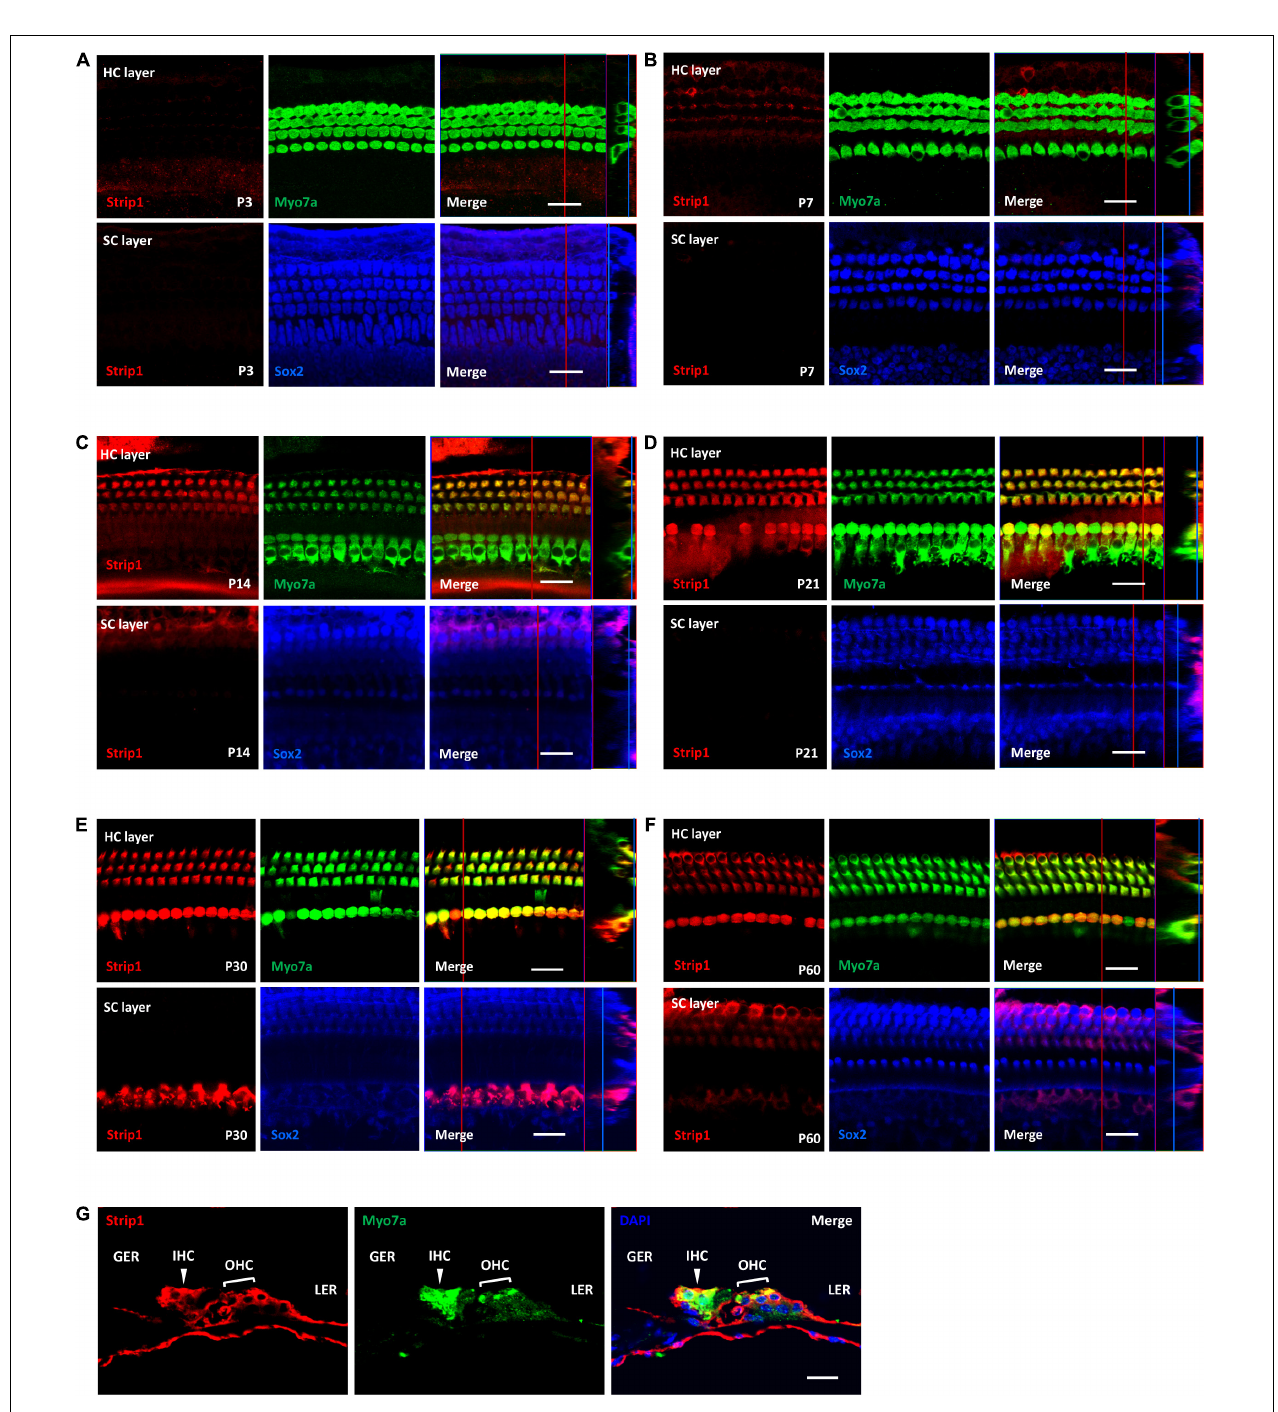
FIGURE 2 | Immunofluorescent staining of Strip1 in the mouse cochlea at different ages. (A–F) The Strip1 antibody was used to stain Strip1 in mouse cochleae at P3 (A) , P7 (B) , P14 (C) , P21 (D) , P30 (E) , and P60 (F) . Because nucleus of SCs staining by Sox2 antibody are not always in the same layer, Z projection was performed with the ImageJ software in order to capture all the SCs in the images. (G) The immunofluorescent staining of P30 cochlear cryosections also showed the same expression pattern of Strip1 . Myo7a and Sox2 were used as HC and SC markers, respectively. Scale bar, 20 µ m.